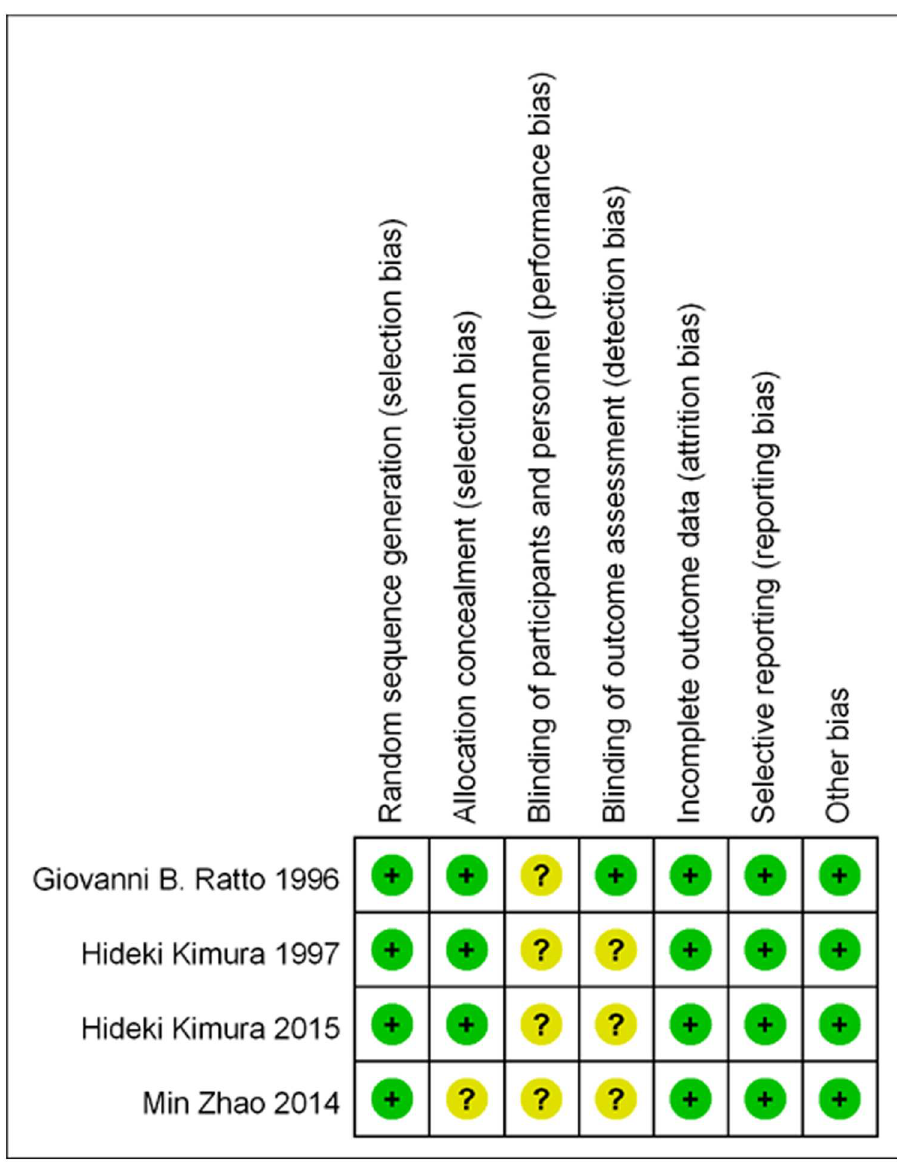
Fig 2. Risk of bias in includedstudies.